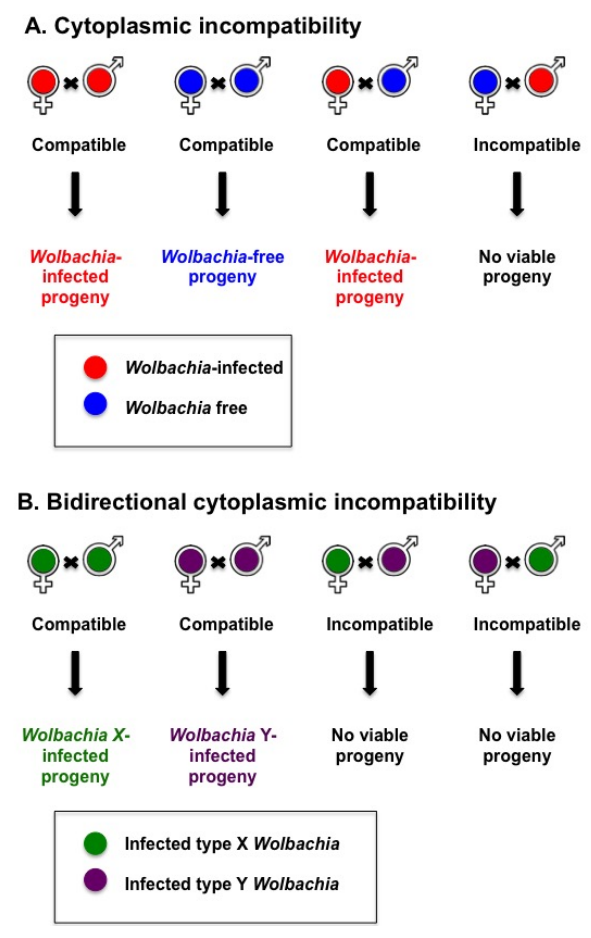
Figure 1. Cytoplasmic incompatibility induced by Wolbachia can lead to an increased number of Wolbachia -infected progeny in the population. ( A ) An incompatible cross arises when a male infected with Wolbachia mates with a Wolbachia -free female; ( B ) Crosses between parents infected with different Wolbachia strains will be incompatible when their Wolbachia strains are incompatible.